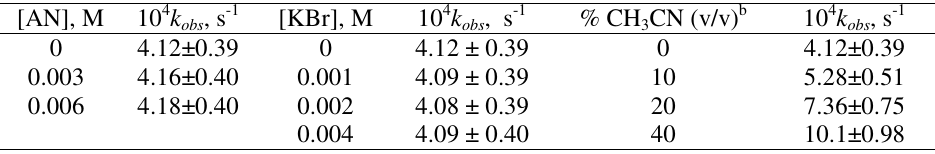
Table 3. Influence of added acrylonitrile (AN), KBr and solvent polarity on reaction rate for [AN],